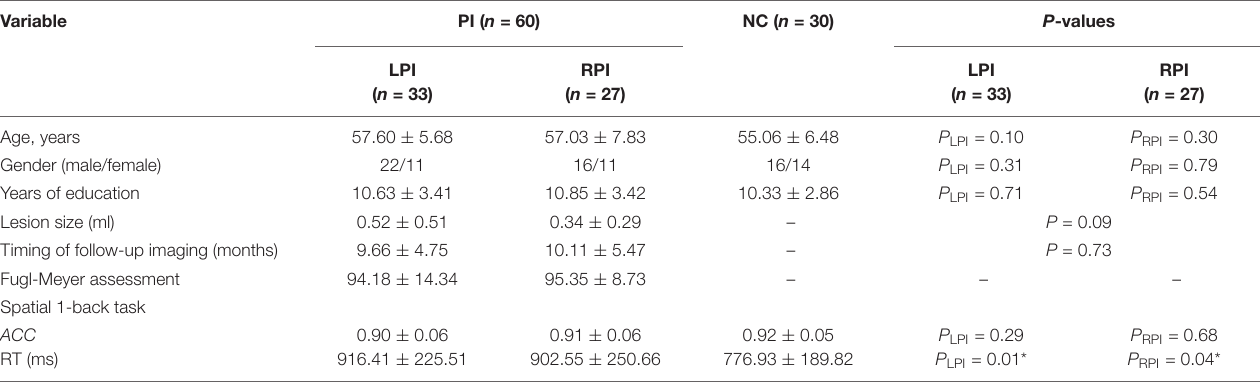
TABLE 1 | Demographic and clinical data of PI and NC groups.